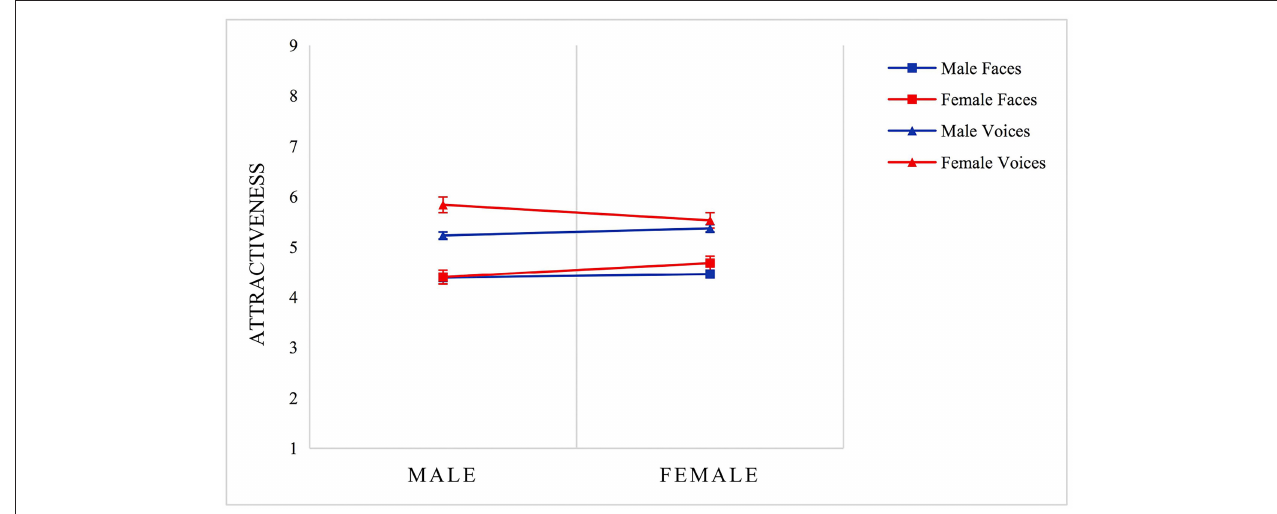
FIGURE 3 | MANOVA analysis of attractiveness of different-sex stimuli × different-sex raters in Study 1. Error bars indicate standard errors of the mean.